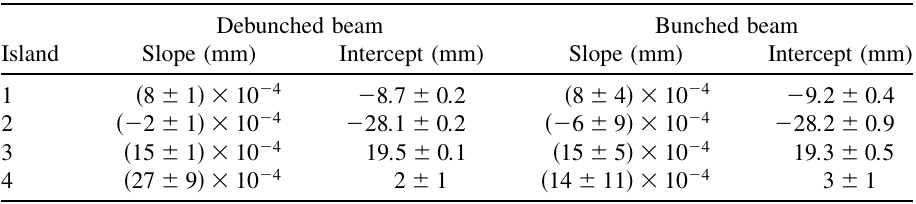
TABLE IV. Comparison of the fit results of the islands’ position (cid:5) i as a function of total beam intensity ( N total in units of 10 10 protons ) obtained from the second experimental campaign for the debunched and bunched beams. The two sets of values are compatible within the error bars. These values cannot be directly compared with those of Table I as they refer to a different location in the PS